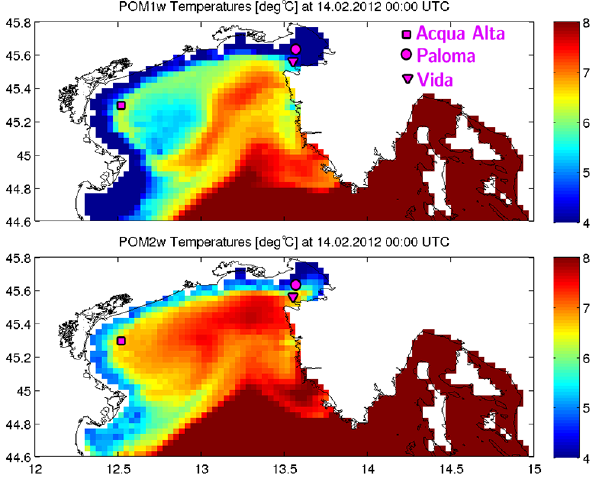
Figure 14. Time averaged ocean currents in POM2w at 1m depth (top panel) and at 12m depth (bottom panel) during 9–14 February 2012,